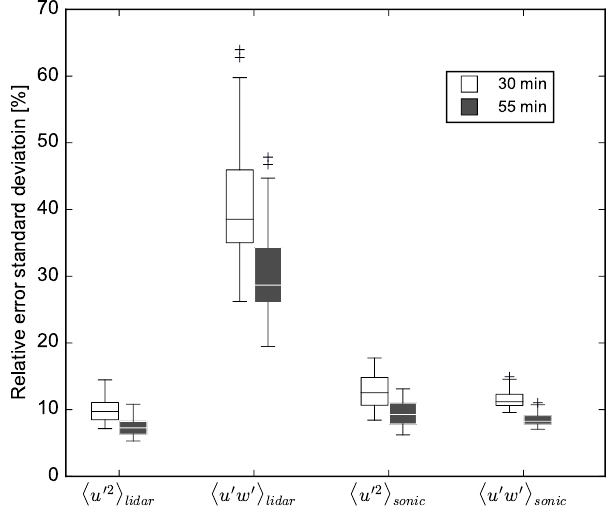
u 0 2 › Figure 15. Box plots of the relative standard deviation of the Figure 14. Variation of the systematic error ( e s ) and variance of streamwise velocity variance (cid:104) u (cid:48) 2 (cid:105) and vertical momentum flux (cid:16) (cid:17) (cid:104) u (cid:48) w (cid:48) (cid:105) , assuming that they are derived from the six-beam method e 2 r random error with respect to the sampling duration ( T ) in (a) from Sathe et al. (2015) (denoted by the subscript lidar) and the and (b) , respectively, predicted from the isotropic turbulence model sonic data (denoted by the subscript sonic) based on the observed (Pope, 2000) and the von Kármán spectra (Burton et al., 2011) at hourly time series in Sect. 4.1. Only those hourly data with (cid:104) u (cid:48) w (cid:48) (cid:105) < 80m height under neutral conditions for surface roughness lengths − 0 . 1m 2 s − 2 are included. Relative standard deviations for the six- ( z 0 ) from 10 − 3 to 10 0 m and LOS orientations β from 0 to 90 ◦ , beam method are calculated using the method in Appendix A and where β is the angle between the LOS and the wind direction. The the observed attenuation and sampling errors in Sect. 4, and those blue lines with squares and the dark lines are the mean error values for sonic data are based on the derived turbulence statistics from the from the entire range of z 0 and β for the averaged and point ra- sonic data described in Sect. 4.1 and error quantification methods dial velocity variance, respectively. The red shaded areas denote the given in Lenschow et al. (1994). The sampling duration is denoted range of errors of the averaged radial variance. The equation used by the colors of box plots (see the to estimate the integral length scale can be found in Wang et al. (2016) with a mean wind speed of 7ms − 1 and Coriolis parameter of 10 − 4 s − 1 . The elevation angle φ = 45 ◦ .